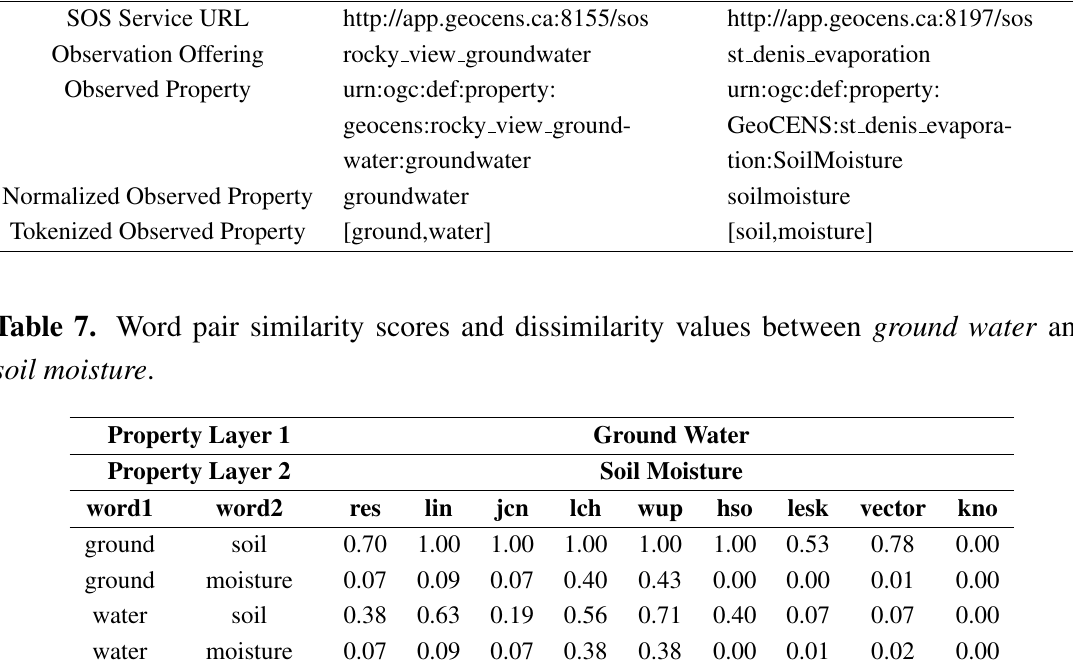
Table 6. Example of tokenization and normalization for two different property layers. SOS Service URL